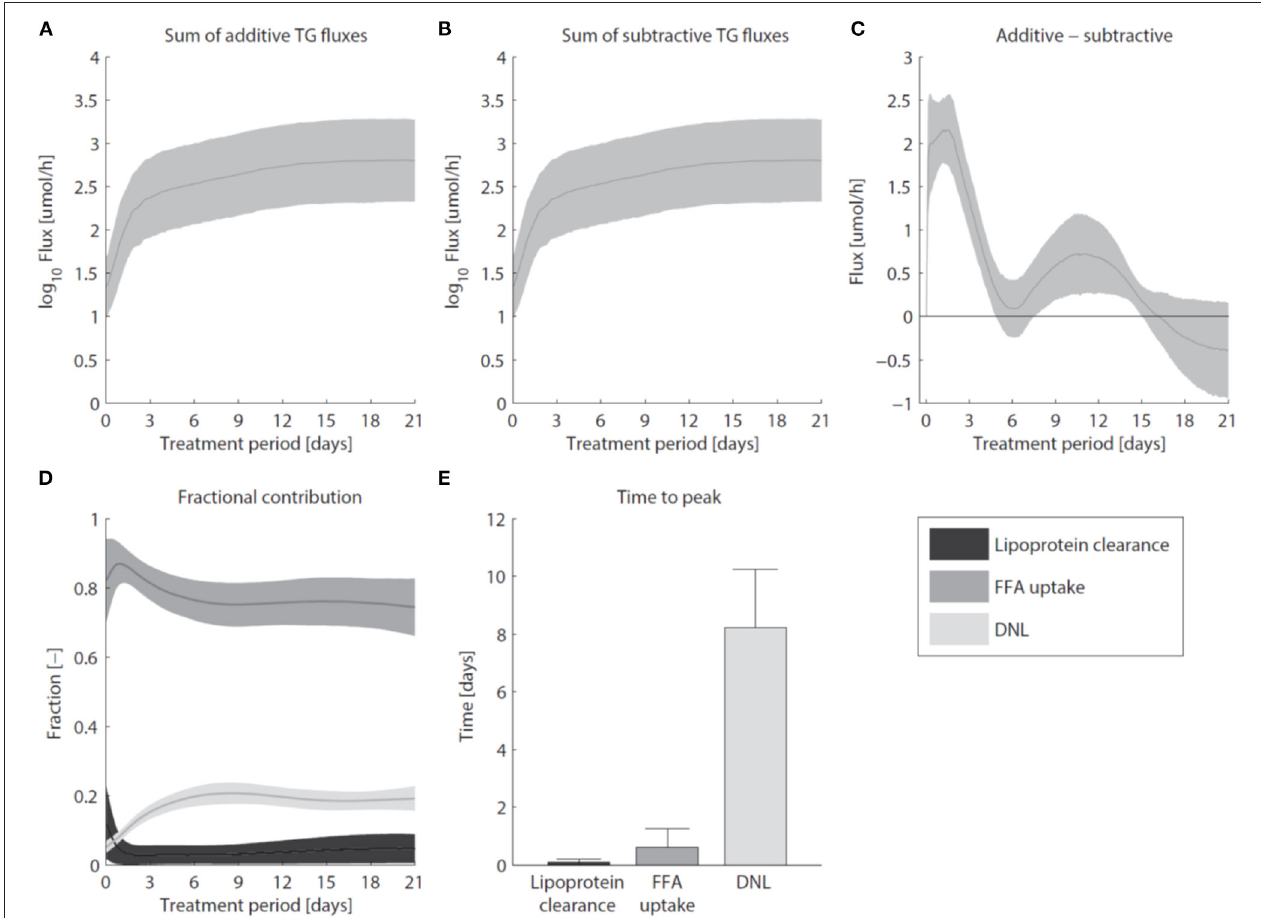
FIGURE 7 | Hepatic accumulation of triglycerides. (A) The sum of fluxes contributing to the hepatic TG pool. (B) The sum of fluxes that catabolize hepatic TG. (C) The difference between additive and subtractive TG fluxes. Note the 10-fold smaller scale of the y-axis in (C) compared to (A,B) . (D) The fractional contribution of the various fluxes included in F a . (E) The time to peak (time to maximal fractional contribution) of the various processes. The areas and bars represent median ± median absolute deviation. The solutions of group G 0.05 are